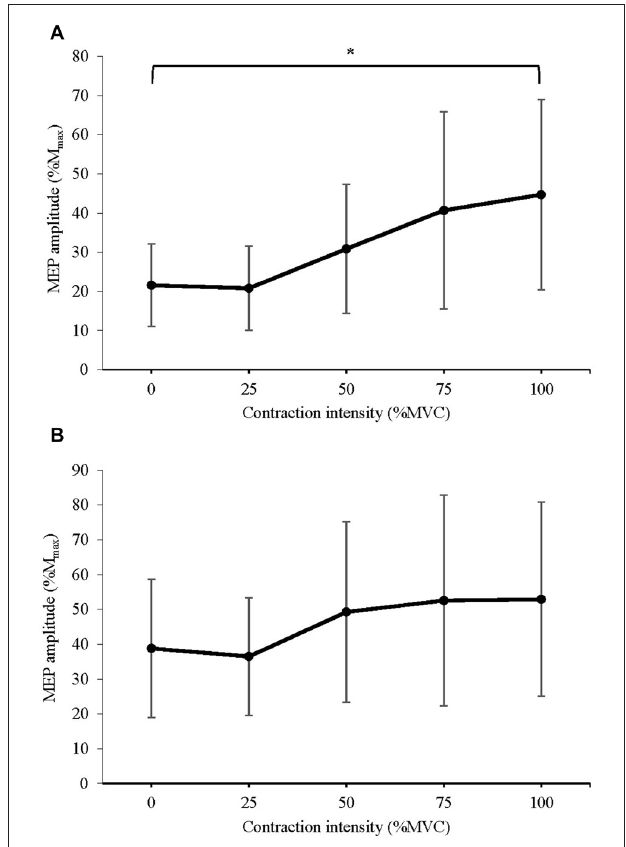
FIGURE 4 | Mean ± SD peak-to-peak amplitude of MEPs delivered at (A) 120% active motor threshold (AMT) and (B) 150% AMT, recorded from the active right RF during isometric contraction of the left quadriceps. ∗ Denotes significant difference in post hoc pairwise comparison ( p < 0.05). For MEPs collected at 120% AMT, contraction at 100% MVC produced a 107% increase in MEP amplitude.